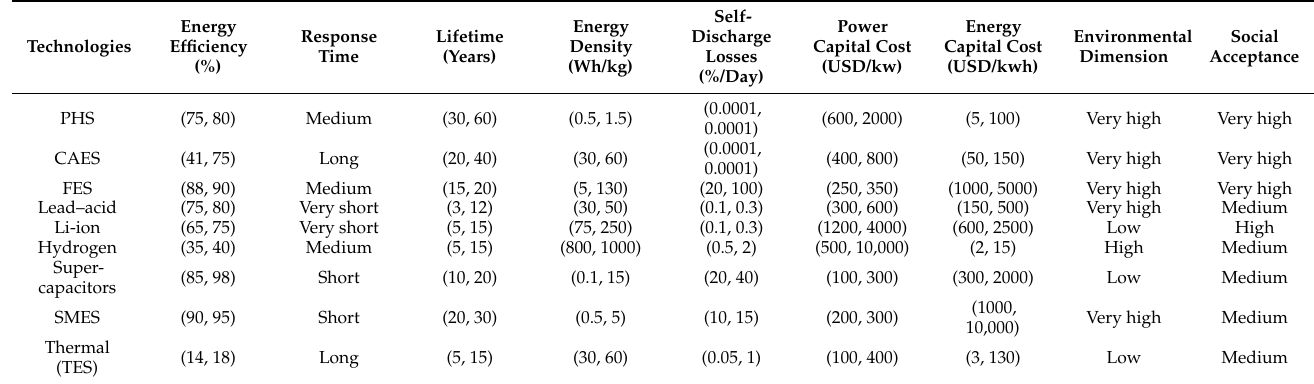
Table A11. Decision basic data of Expert 7.